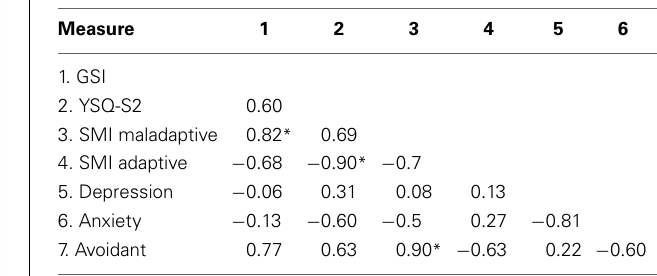
Table 2 | Pearson correlations between GSI scores, depression, anxiety, avoidant, YSQ-S2, and SMI at